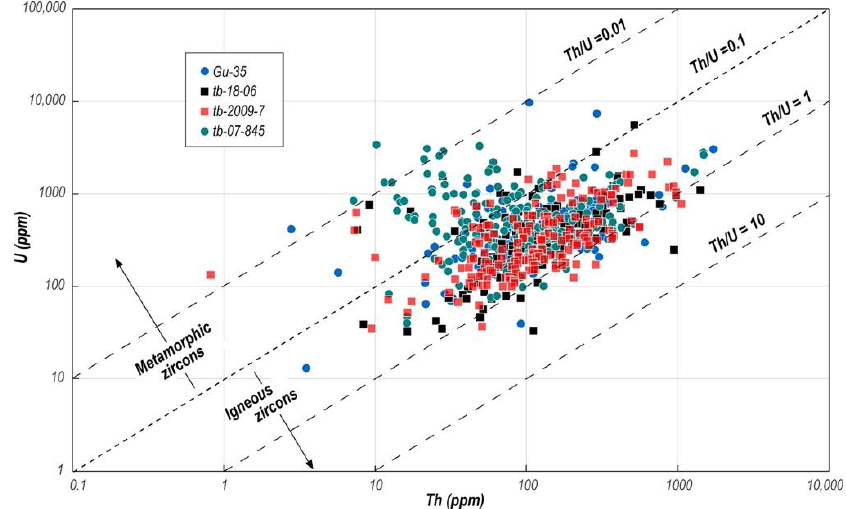
Figure 5. U vs Th compositional diagram of analysed zircons.